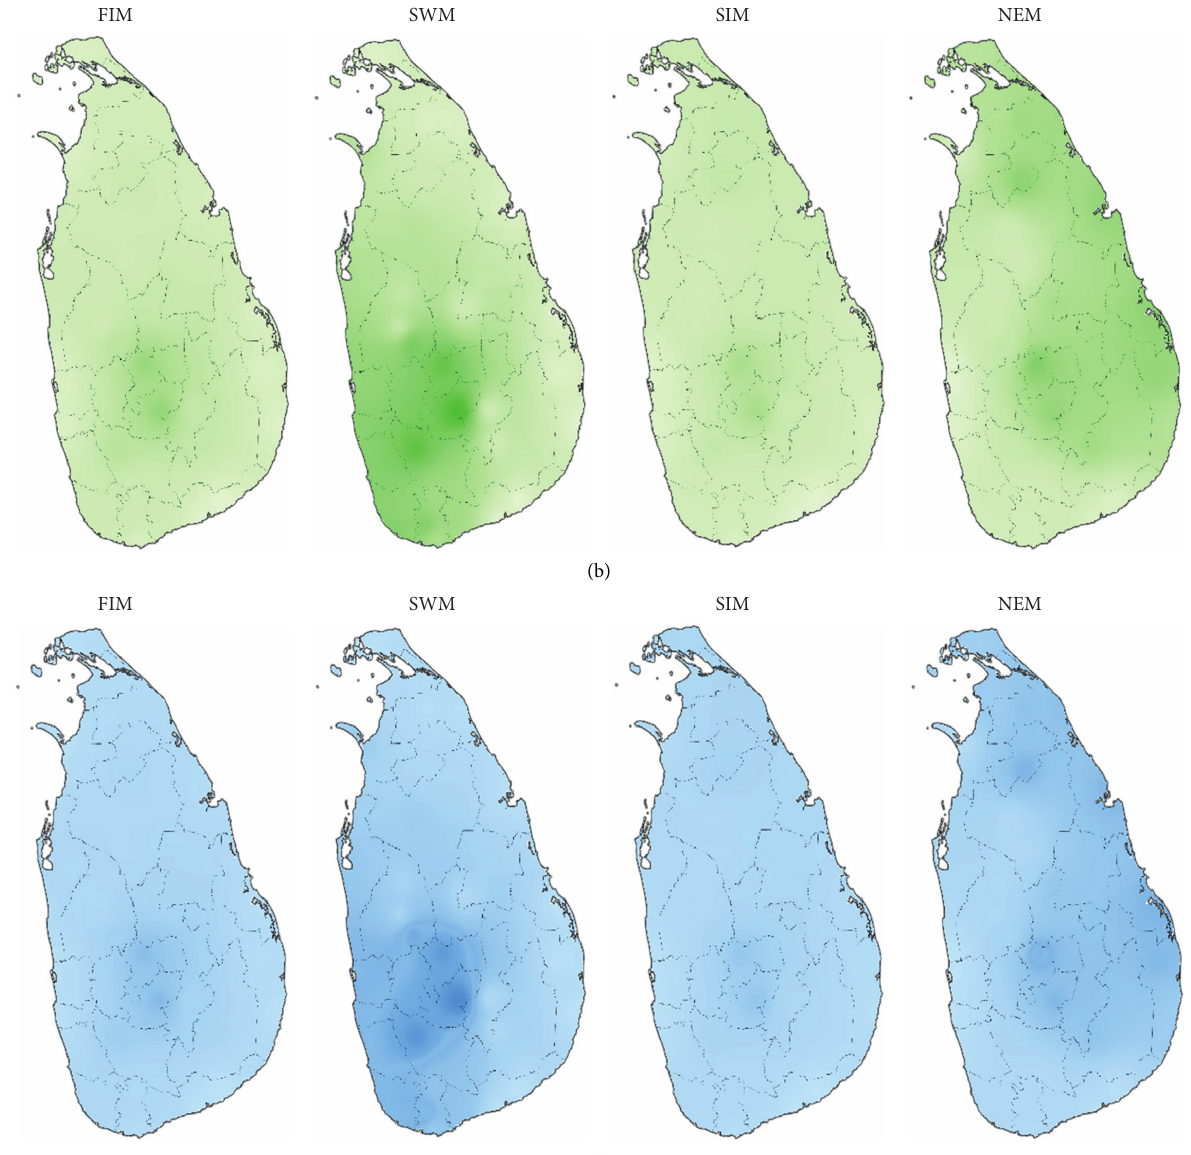
Figure 6: Mid-future indices under RCP8.5 (2041–2070) (a) For normalized DI. (b) For normalized WI. (c) Moisture